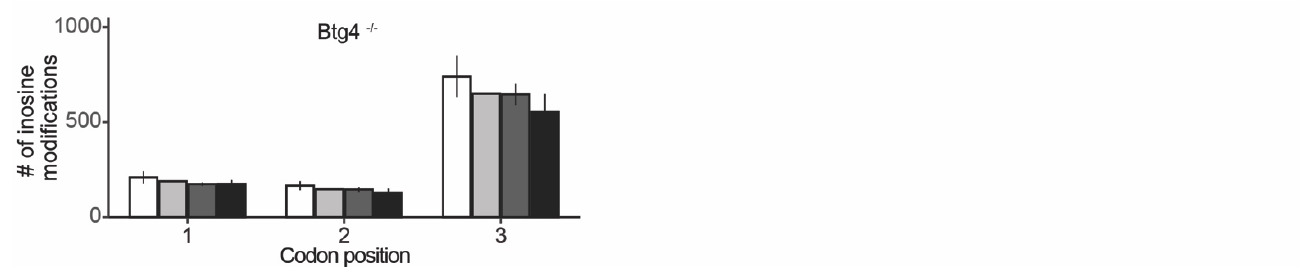
Figure 5. Inosines are enriched at the wobble position of codons in total RNA and ribosome-associated RNA. ( A , B ) Global frequency of inosine RNA modifications at the first, second, or third codon positions in WT, Cnot6l -/- , and Btg4 -/- samples in total RNA ( A ) and ribosome-associated RNA ( B ). Only codons from transcripts with TPM ≥ 1 were analyzed.